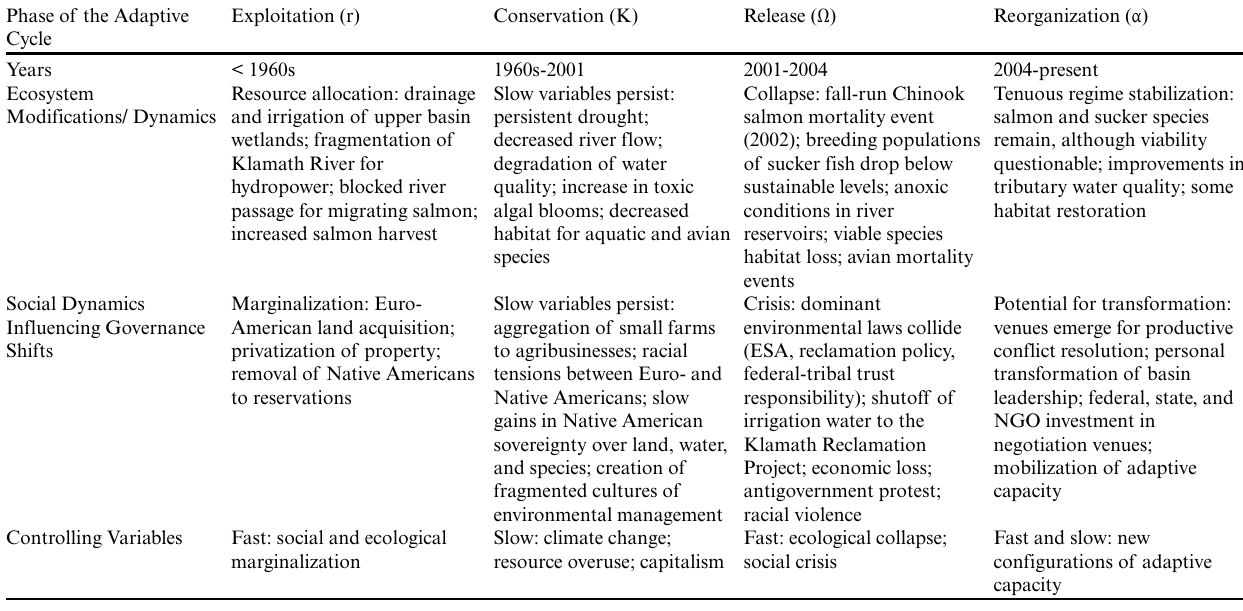
Table 6 . Resilience assessment of the Klamath River Basin social-ecological system (SES). The Klamath River Basin contains a unique river system originating in the arid interior of southcentral Oregon west of the Cascade Range and flowing through the mountainous rain shadow of northern California toward the Pacific Ocean. During the course of human history in the basin, the overall resilience of the basin to regime shift has oscillated according to interactions between forces of environmental governance and ecological responses, originating both from within and beyond the basin. To better understand the contemporary resilience of the Klamath River Basin to disturbance and sudden change, it is helpful to investigate and map historic patterns of system change through the adaptive cycle metaphor of SES dynamics. Below we employ the phases of the adaptive cycle to describe the dynamics of the most recent iteration of this cycle in the Klamath Basin. Although we recognize that several scales of nested cycles likely contribute to and further describe the dynamics portrayed here, the basin scale is a helpful unit of analysis to feedback to both social and ecological aspects of